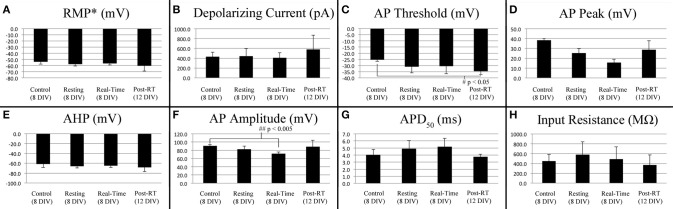
Current stimulated action potential attributes. Data represents averages attained from non-stretched controls (8 DIV, n = 4), stretch-grown cells at rest following initial stretch-growth (Resting, 8 DIV, n = 3), stretch grown cells during real-time stretch (Real-Time, 8 DIV, n = 3), and cells at rest 3–4 days following real-time stretch (Post-RT, 12 DIV, n = 3). (A) Resting membrane potential, (B) Depolarizing current, (C) Activation threshold, (D) Peak voltage, (E) After-hyperpolarization voltage, (F) Amplitude, (G) Action potential duration at 50% amplitude, (H) Input resistance. Graphs show mean ± standard deviation; *uncorrected.